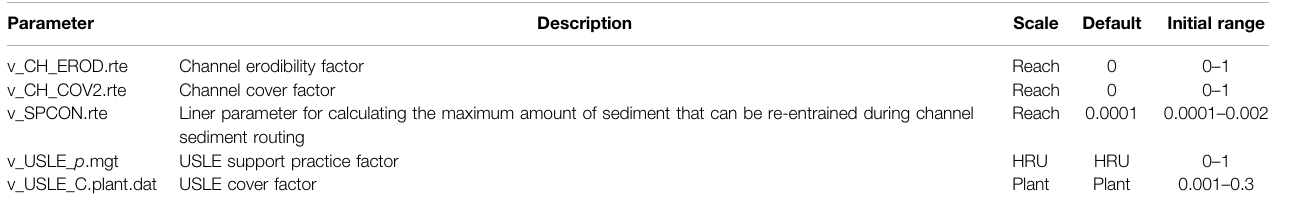
TABLE 2 | Parameters used for sediment load